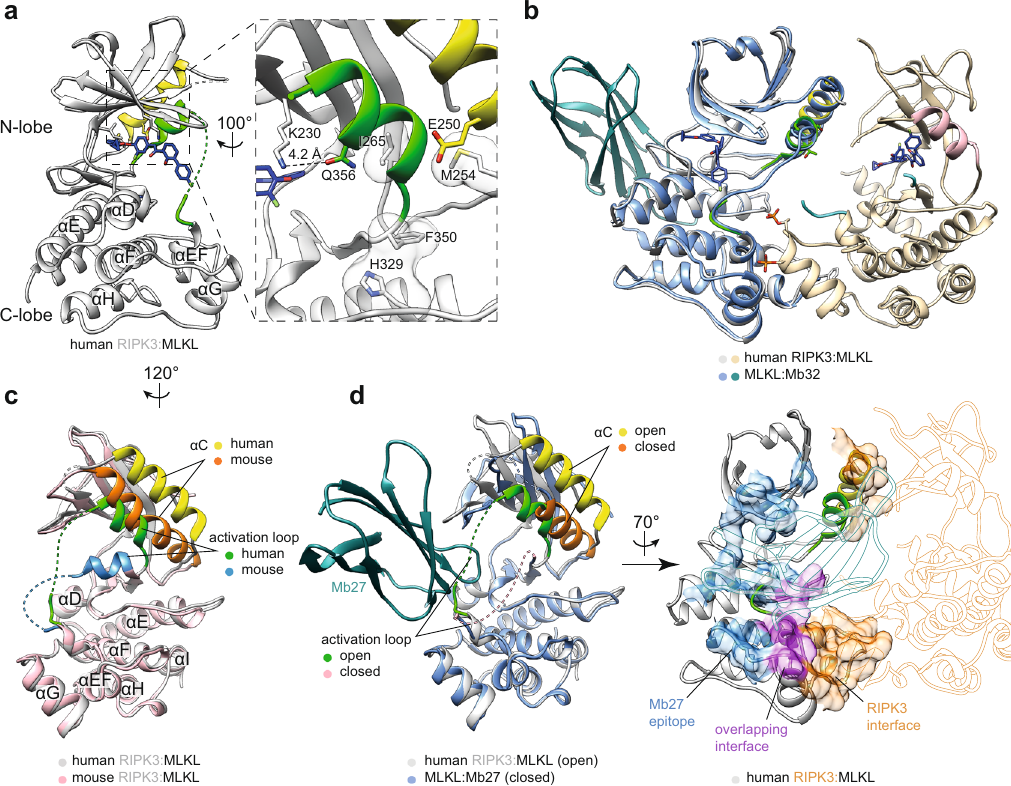
Fig. 2 Human MLKL adopts an open conformation in complex with RIPK3. a Human MLKL pseudokinase domain (gray) from the co-crystallized complex with RIPK3. The α C helix (yellow), activation loop (green), and Compound 10 (blue sticks) are highlighted. Zoomed view on the right illustrates the open, inactive conformation adopted by MLKL. R-spine residues (gray sticks with transparent surfaces) are misaligned; the K230 – E250 salt bridge interaction is disrupted by the activation loop helix supplanting the α C helix, and contributing Q356 to the interaction with K230. b Superimposition of the human MLKL (blue):Mb32 (teal) complex (PDB: 7JXU) 47 with the MLKL (gray):RIPK3 (wheat) complex reported herein (PDB: 7MON). c Superimposition of the human (gray) and mouse (pink) MLKL structures from their complexes with RIPK3 from superimposing the respective MLKL protein in each complex model. Human complex (this study; PDB: 7MON); mouse, (PDB: 4M69) 46 . The α C helix (human, yellow; mouse, orange) and activation loop (human, green; mouse, blue) are highlighted. Viewing angle is rotated by 120° clockwise around the y -axis from the position in panel a . d A monobody (Mb27) that binds human MLKL post-release from the necrosome (left, teal; PDB: 7JW7) 47 binds MLKL via a site that overlaps the human RIPK3-binding site (right; MLKL, gray; RIPK3, wheat). The MLKL α C helix (yellow) and activation loop (green) are highlighted. Left, superimposition of the human MLKL (blue):Mb27 (teal) complex with the MLKL:RIPK3 complex (same viewing angle as panel c ). Right, the binding epitopes on human MLKL are shown as surfaces in the cartoon (same viewing angle as panel b ); the Mb27 binding epitope is shown in blue, the RIPK3 epitope in orange and the overlapping interface in magenta. Mb27 and RIPK3 models are shown as silhouettes. All superimpositions were performed using UCSF Chimera pro fi les (Supp. Fig. 1f, χ 2 = 0.614 and 0.661 for apo and Com- pound 10-bound complexes, respectively), indicating that the heterodimer present in the crystal structure is representative of the biological assembly in solution.